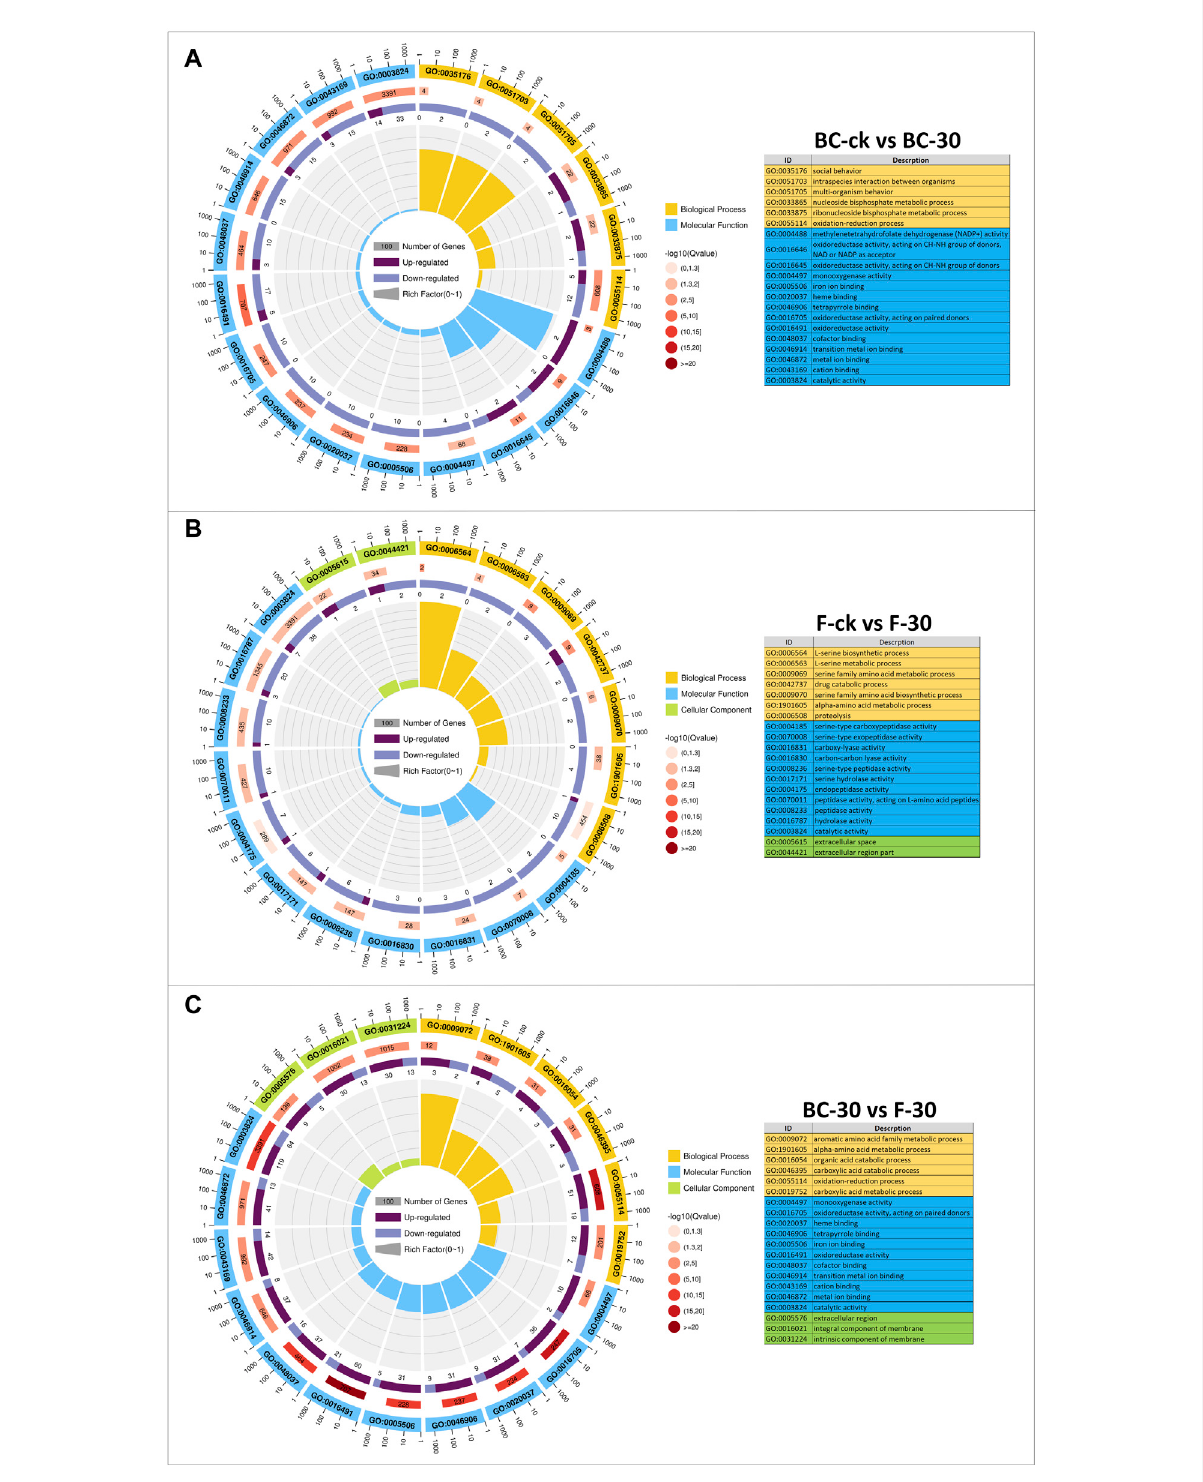
FIGURE 3 GO classi fi cations (A) (BC-ck vs. BC-30 (B) F-ck vs. F-30, and (C) BC-30 vs. F-30. Biological processes, cellular components, and molecular functions are indicated in different